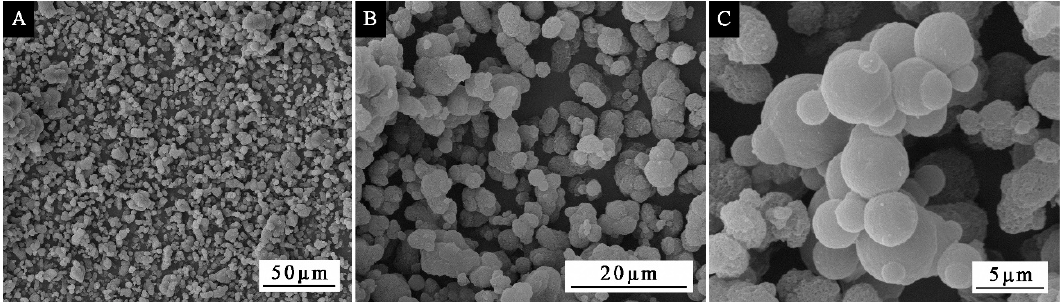
Figure 9. SEM morphology of microcapsule prepared under two months of deposition: ( A ) low magnification, ( B ) middle magnification, ( C ) large magnification.